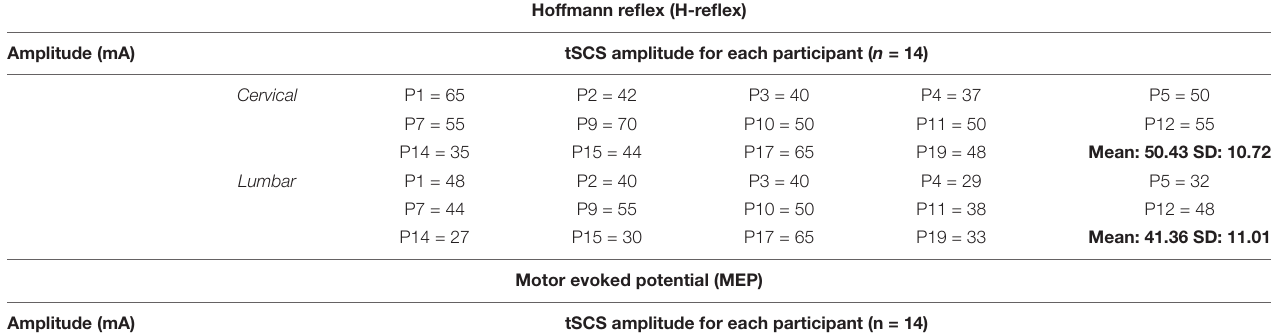
TABLE 1 | Summary of tSCS amplitude across study participants.